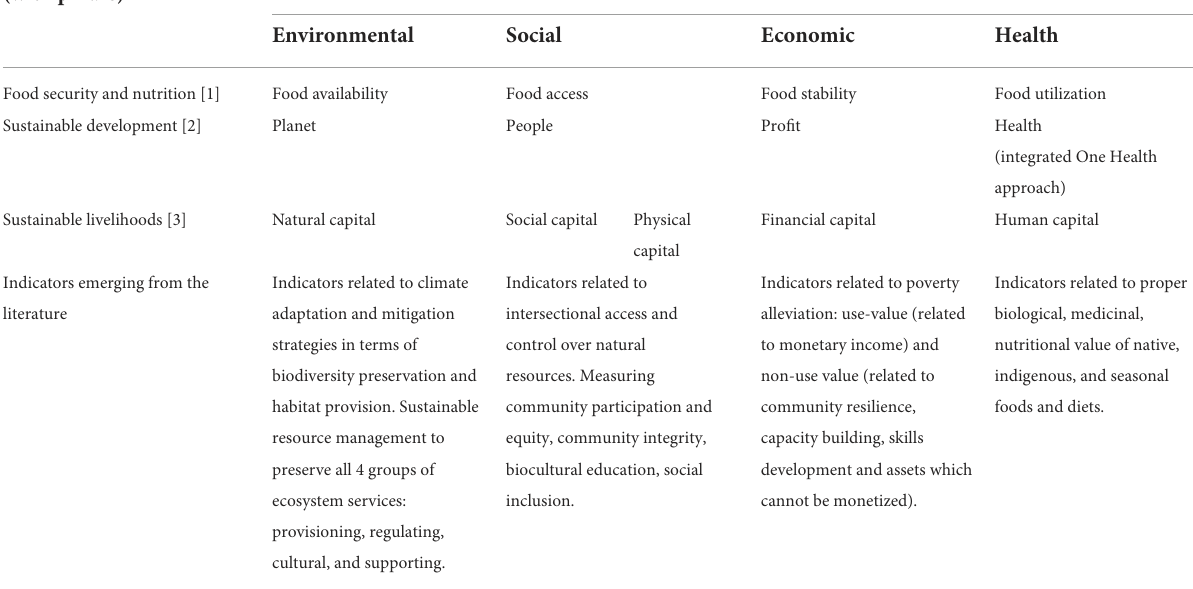
TABLE 1 Four common literature dimensions emerging from 3 theoretical frameworks (source: authors). 3 Theoretical